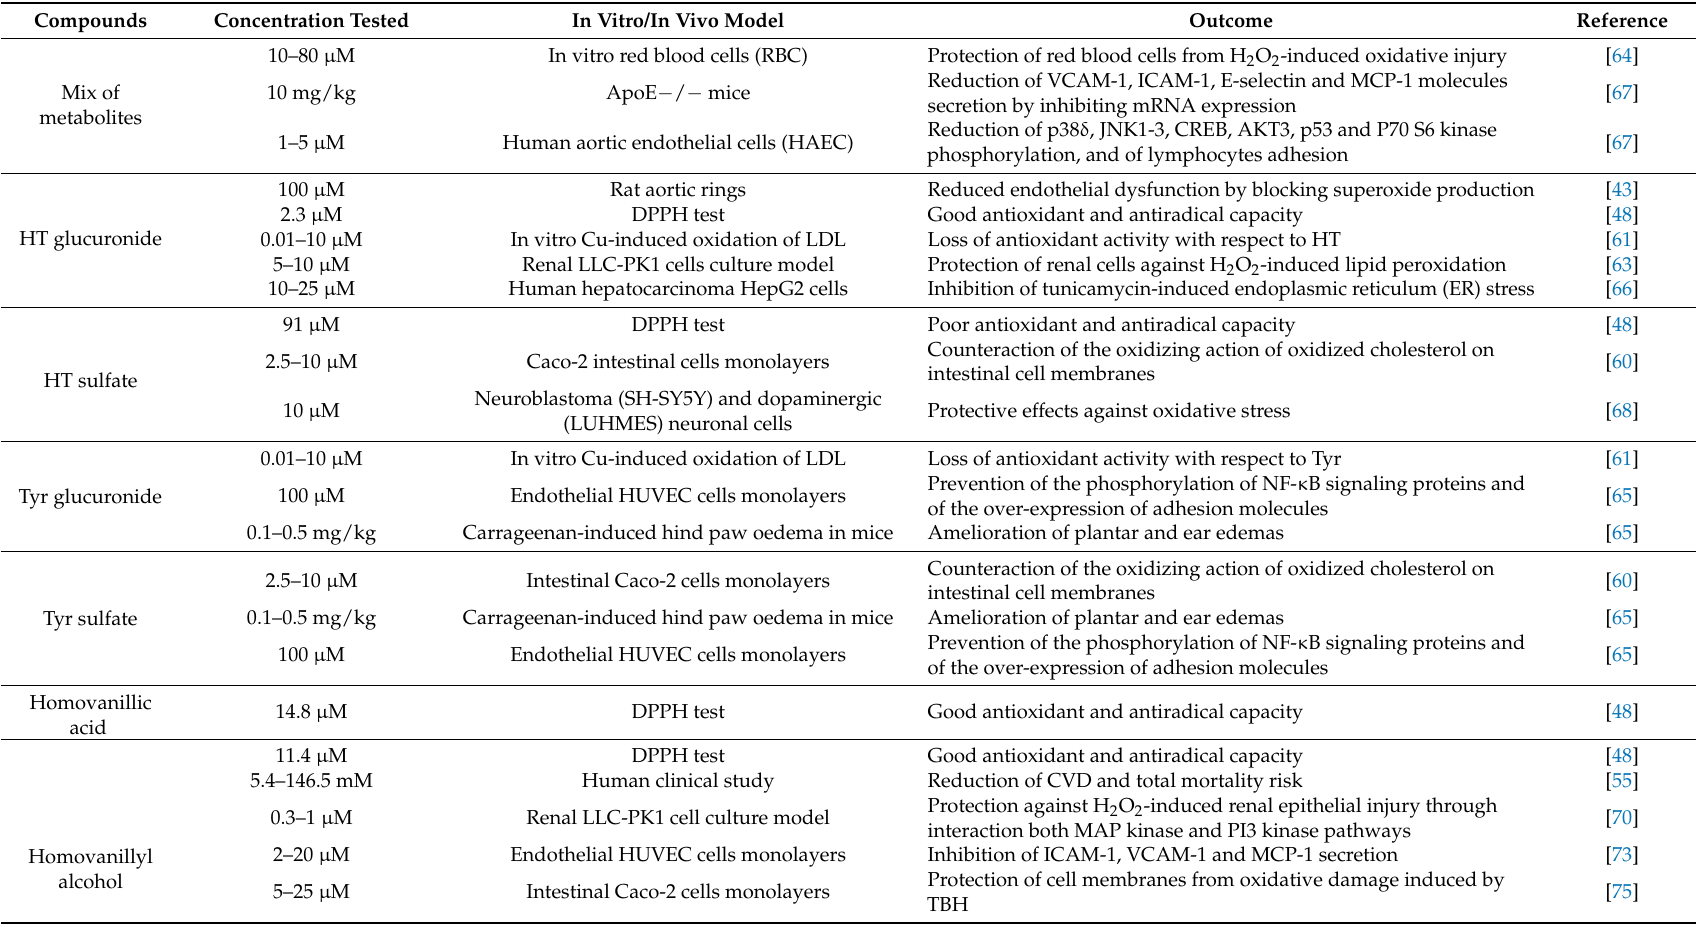
Table 1. Olive oil polyphenols metabolites and their activities in different in vitro and in vivo experimental